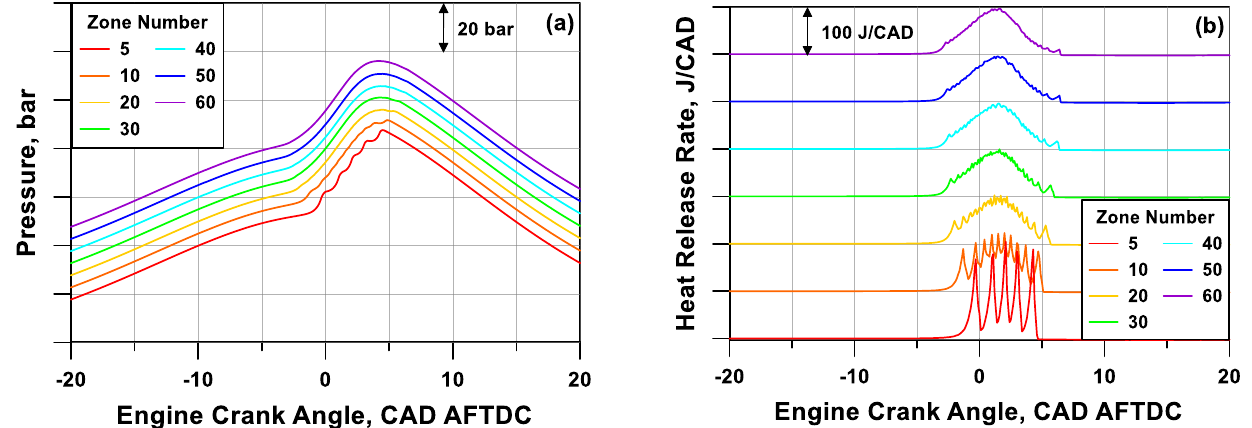
Figure 8. The sensitivity analysis on the number of zones: shifted pressure profiles ( a ) and shifted heat release rate ( b ).